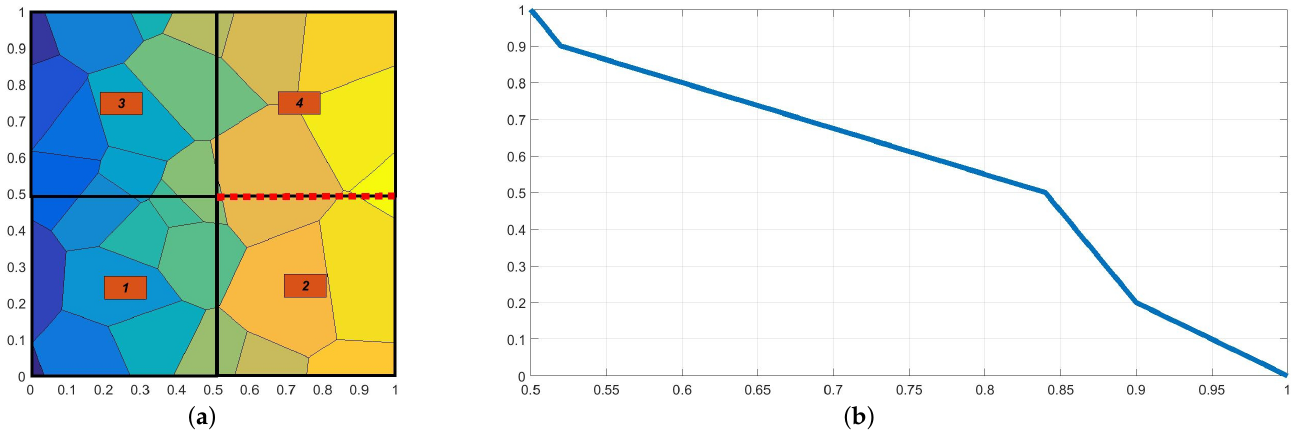
Figure 3. Exemplary shape function assessment: ( a ) analyzed domain—colors denote various thermal conductivities of the constituent, ( b ) modified linear shape function along the dotted